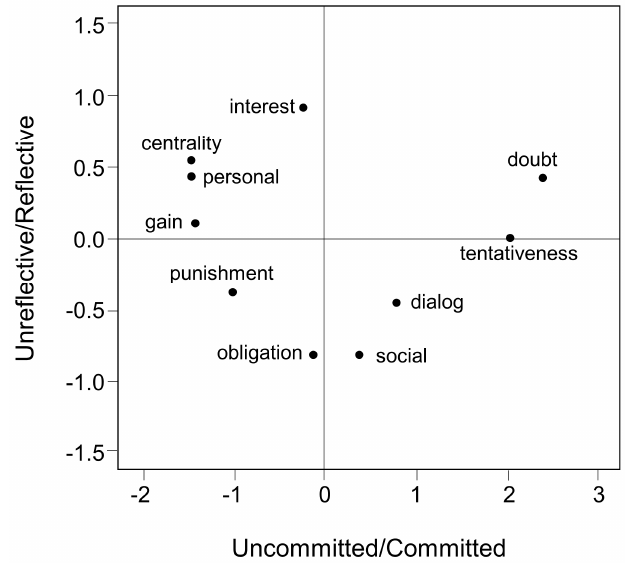
Figure 3. MDS Euclidean distance model of the CROI in the National Quota sample.